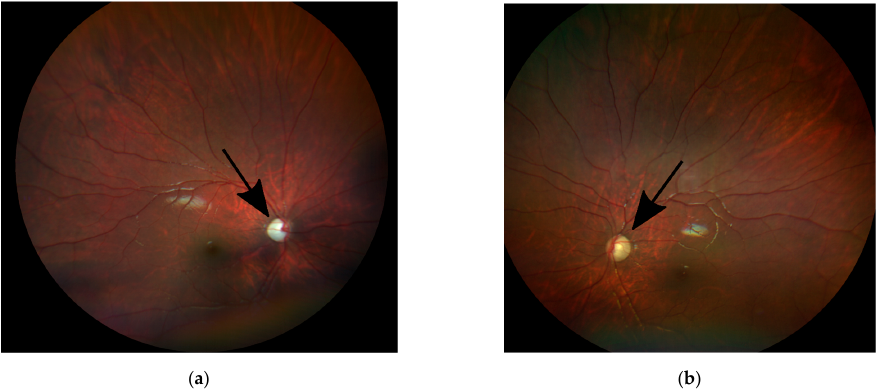
Figure 1. Fundus photos of the right ( a ) and left ( b ) eyes of the child showing diffuse optic disc pallor in both eyes (black arrows). The patient had no strabismus. Cycloplegic refraction showed low myopia and astig- matism. Sedated full-field electroretinogram (ffERG) was virtually normal, showing low normal dark-adapted ERG with normal light-adapted ERG amplitudes (Figure 2a). Mag- netic resonance imaging (MRI) of the brain with and without contrast at the time of presentation was normal. Awake, flash visual evoked potential (fVEP) was recordable and showed low amplitudes and delayed latency OU, OD worse than OS. (Figure 2b). The optical coherence tomography (OCT) showed formed fovea and thinning of the retinal nerve fiber layer (RNFL) OU. (Figure 3a,b). All of the above findings were highly sugges- tive of optic nerve pathology.